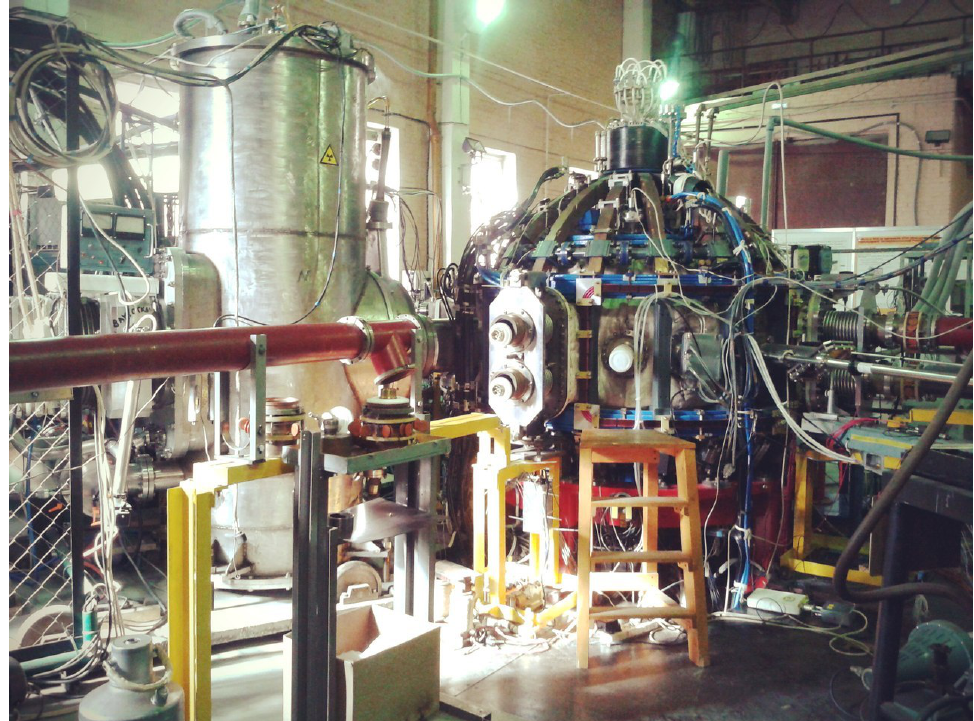
Figure 3. Globus-M2 tokamak (©Ioffe Physics and Technology Institute of RAS, St. Petersburg,